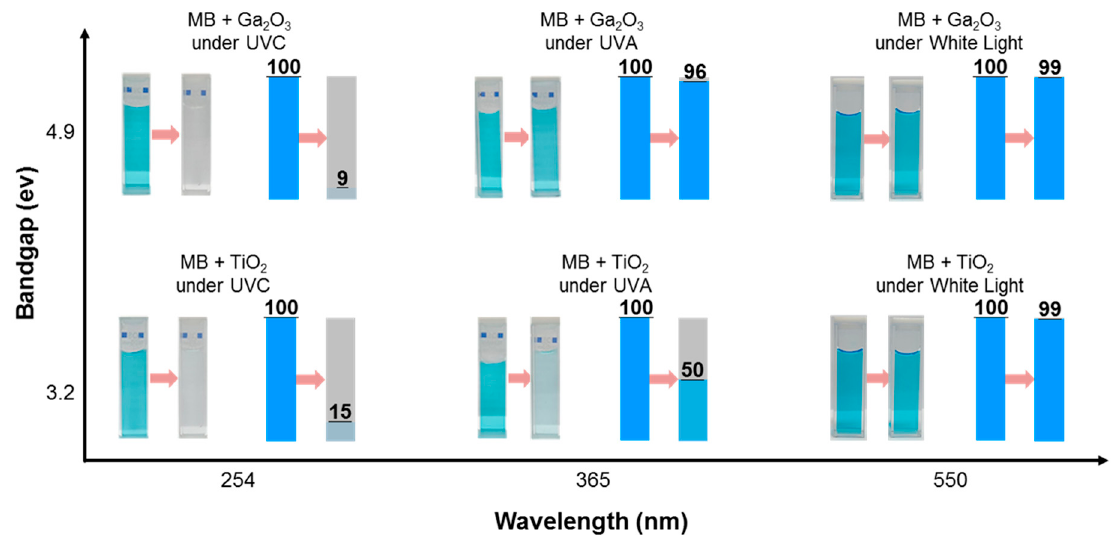
Figure 4. Schematic matrix for the UVC sensor application via the photoelectrochemical reaction of Ga 2 O 3 and TiO 2 based nanomaterials at either 254 nm (11 W), 365 nm (20 W), or 550 (14 W). Each sample was exposed for 3 h, and the relative MB degradation was also quantified for convenience.